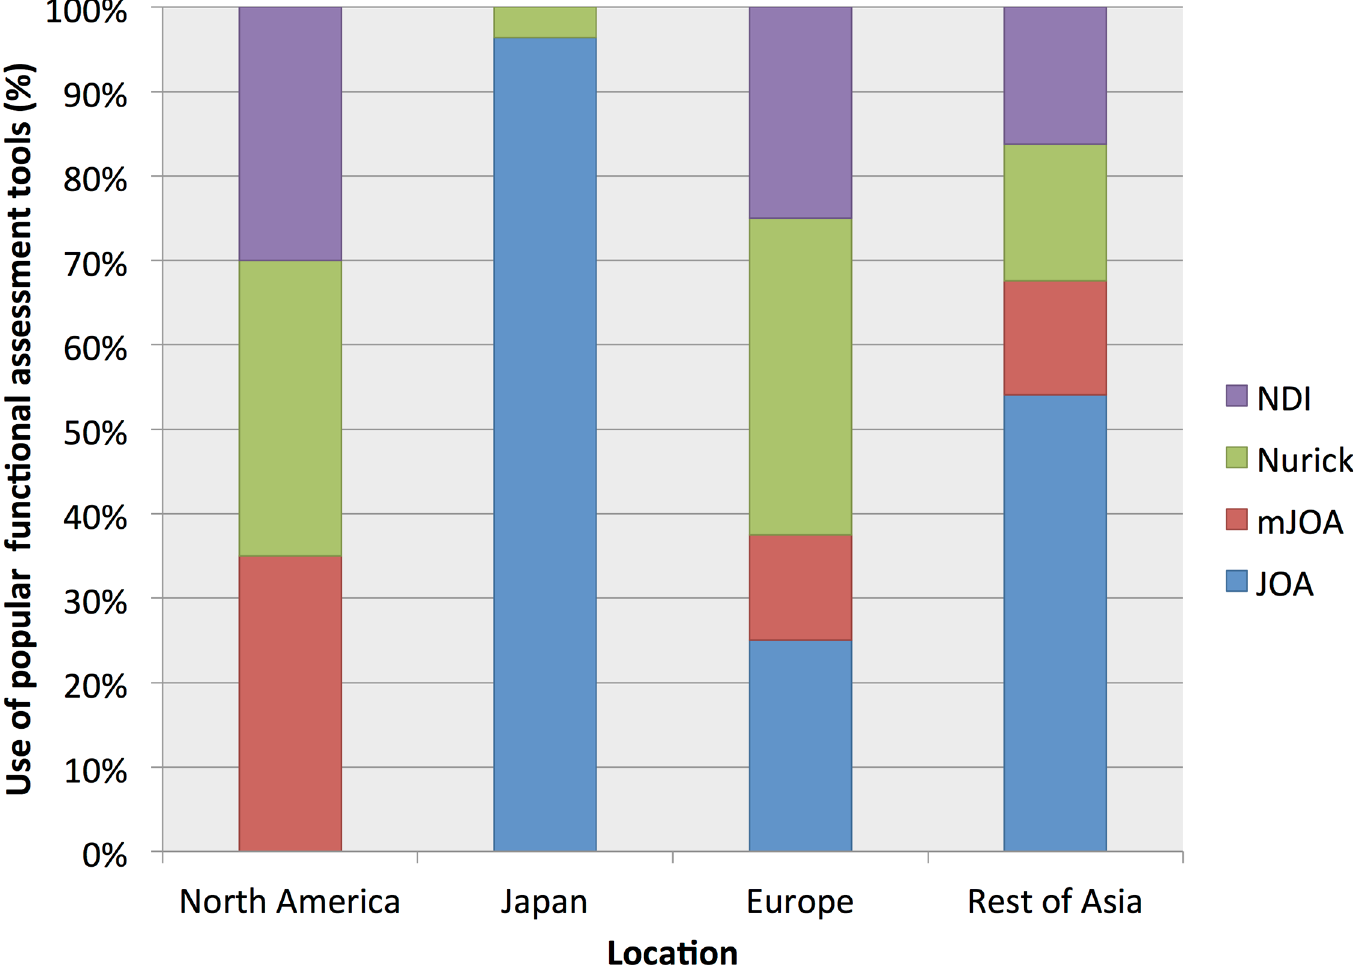
Fig 4. Geographical variation in chosen functional outcomes. Each bar represents 100%. The use of the most prevalent outcome measures (JOA, Nurick, NDI, mJOA, JOACMEQ) are reported as percentages for each territory.